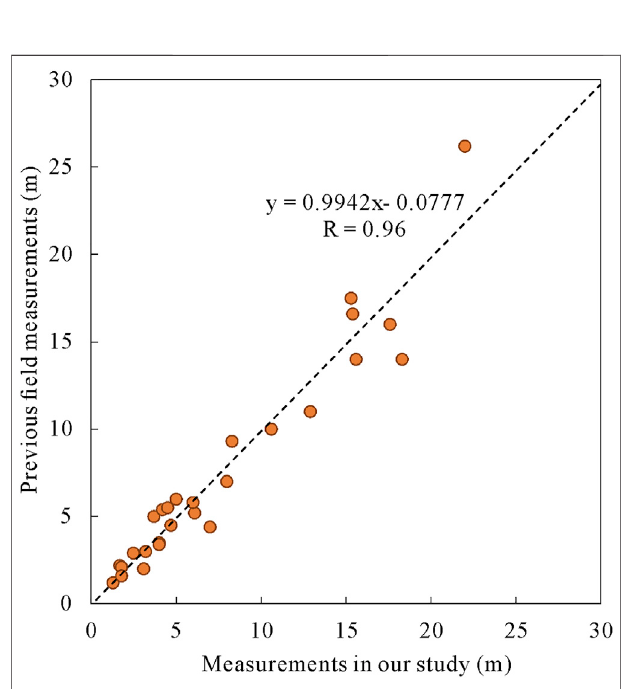
FIGURE7| Scatterdiagram displaying thecomparison betweenvertical displacementmeasurementsinourstudywithprevious fi eldmeasurementsof Chen